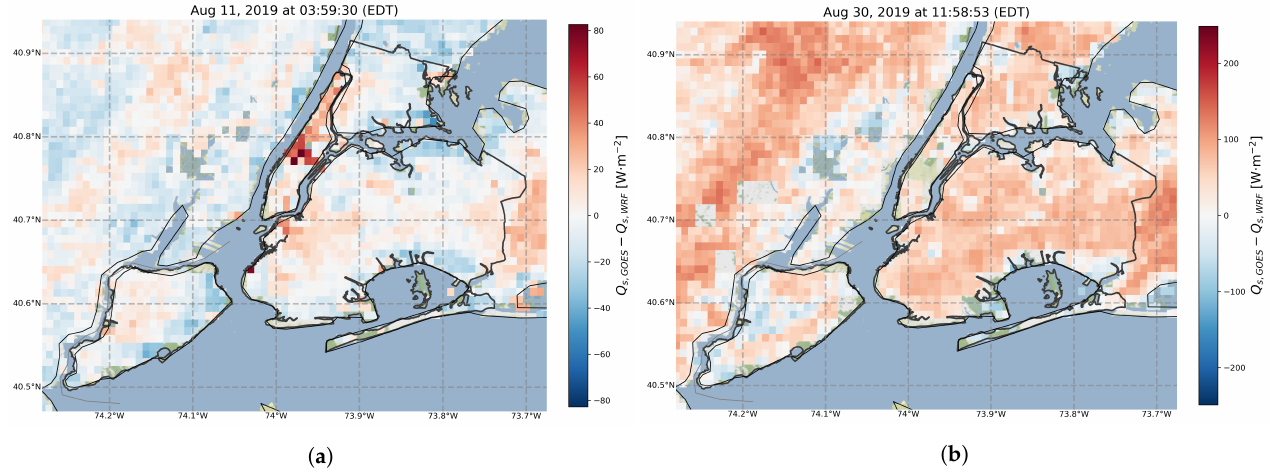
Figure 6. Spatial representation of heat storage estimates by the GOES-16 thermal variability scheme and the uWRF surface energy balance residual: ( a ) nighttime comparison (mean absolute difference: 10 W · m − 2 ); and ( b ) daytime comparison (mean absolute difference: 45 W · m − 2